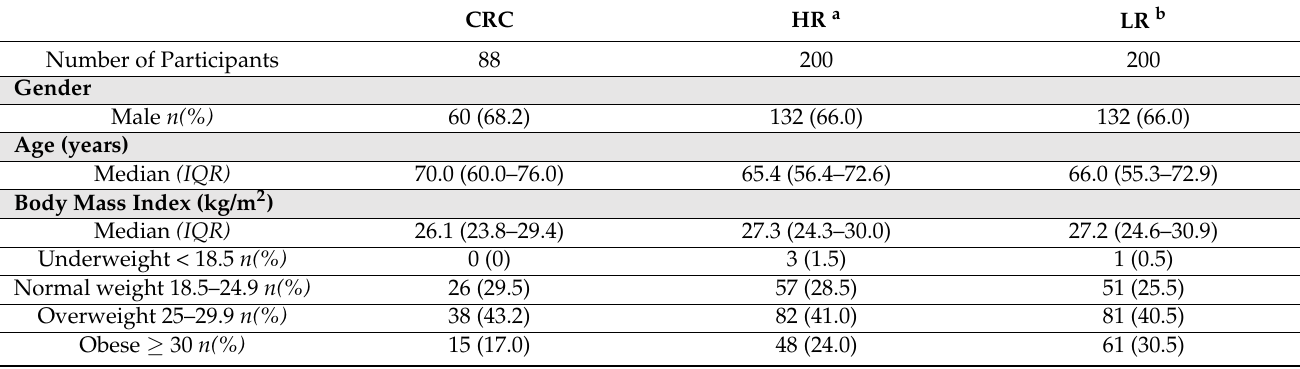
Table 1. Demographics and clinical characteristics of the study population ( n =